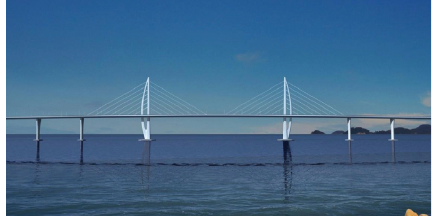
Figure 1: Jiuzhou Shipping Channel Bridge.